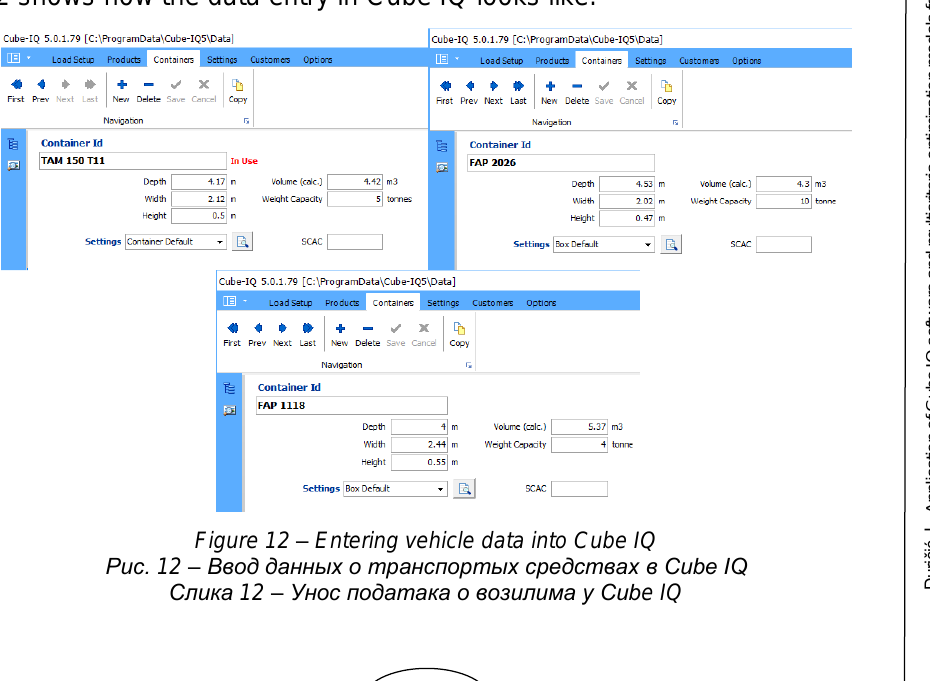
Figure 12 – Entering vehicle data into Cube IQ Рис. 12 – Ввод данных о транспортых средствах в Cube IQ Слика 12 – Унос података о возилима у Cube